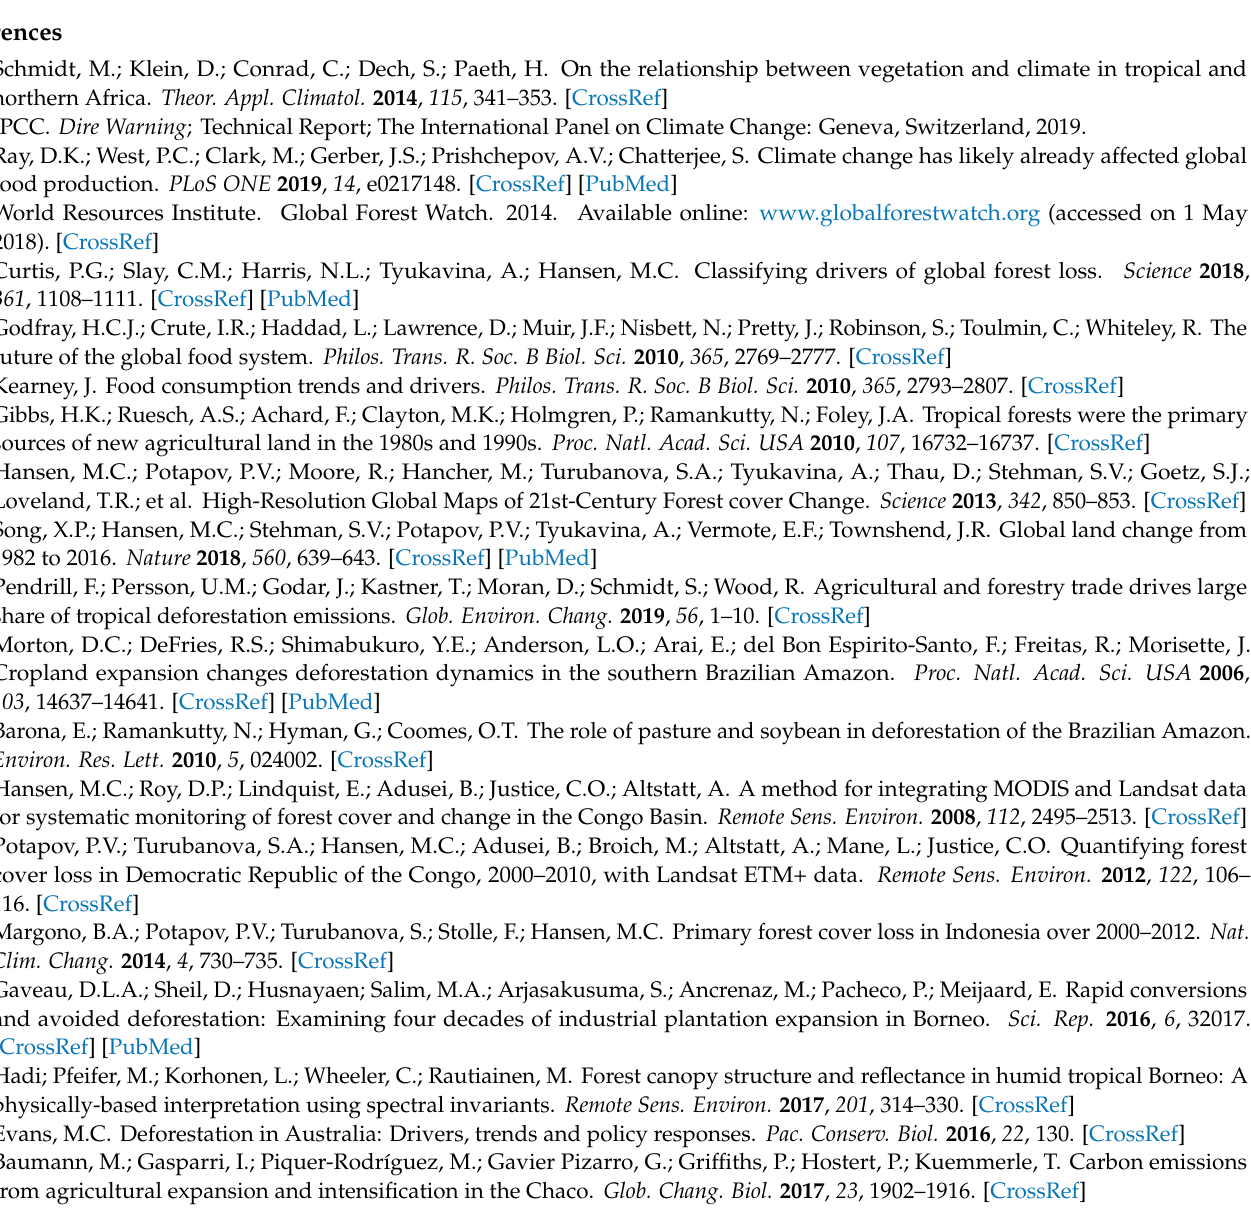
Figure A6. Annual land cover estimates in the Paraguayan Chaco. Each inset is approximately 1 km × 1